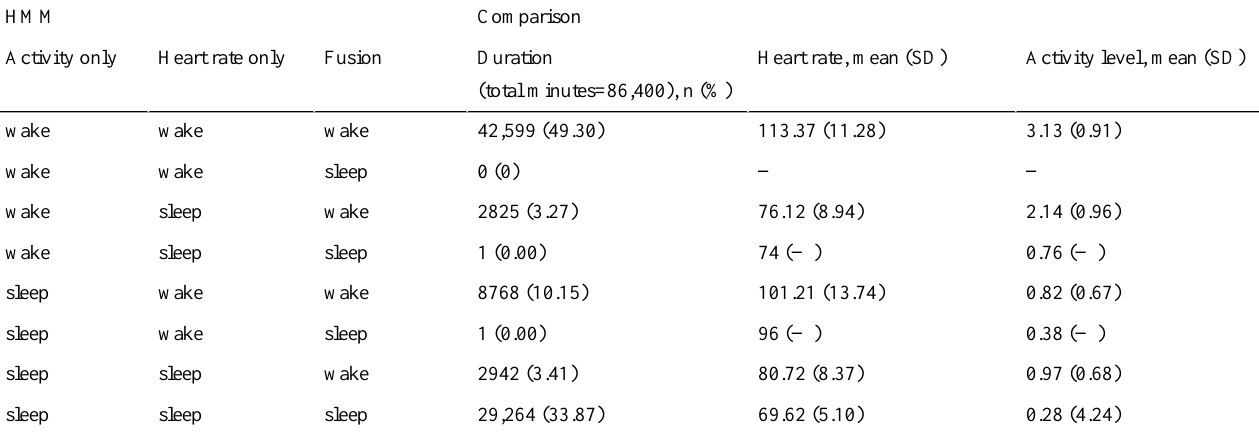
Table 4. Comparison between the activity HMM, the heart rate HMM, and our fusion approach for participant EL02.